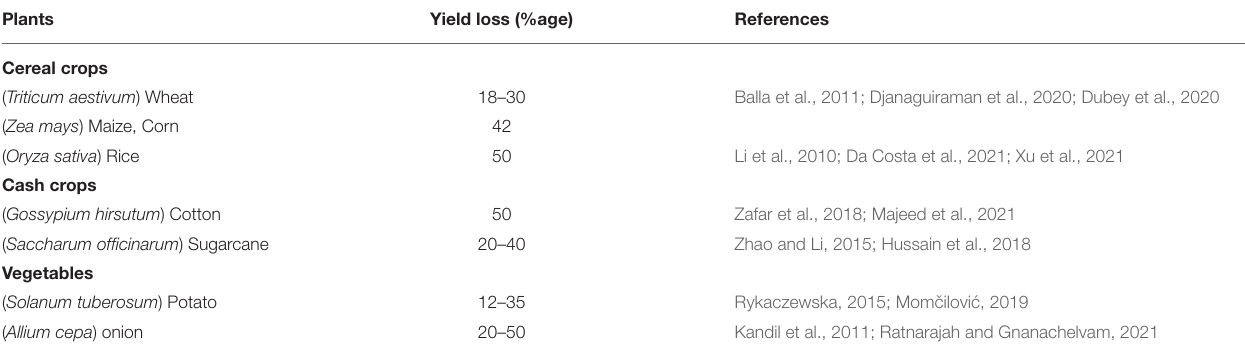
TABLE 3 | Yield losses reported in different crops due to heat stress.